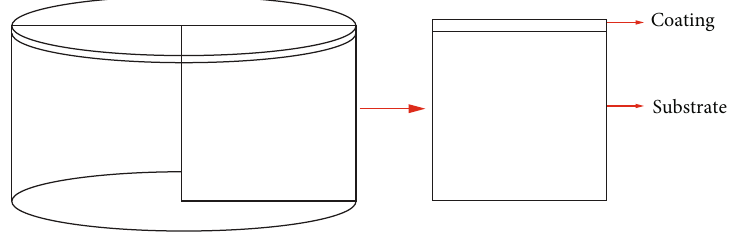
Figure 2: The geometry of the model. Table 1: Properties of the coating and substrate (25 ° C).